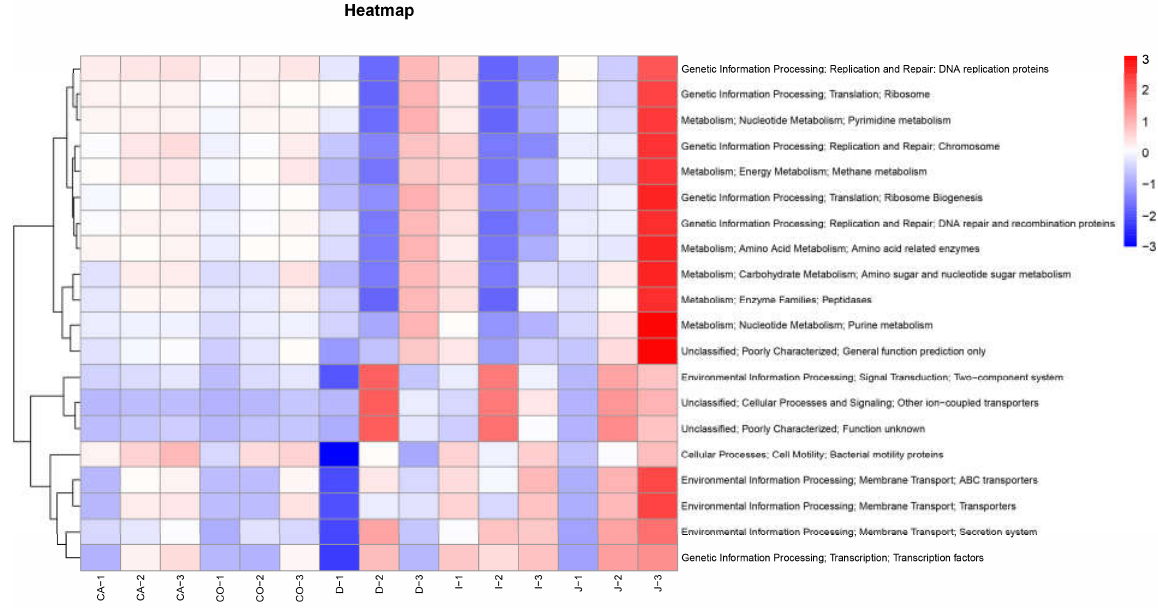
Figure 6. PICRUST annotates relative abundance cluster heat map among different samples of Hai-